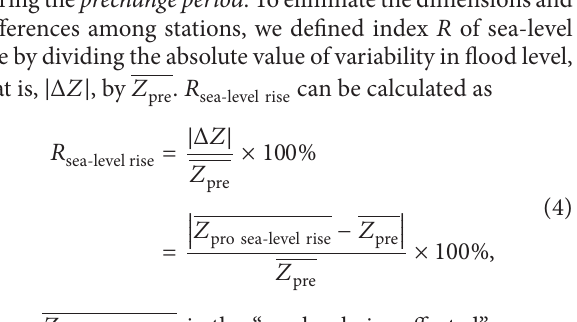
2.15, 1.75 for Nansha, 1.83 for Wanqinshaxi, 3.10 for